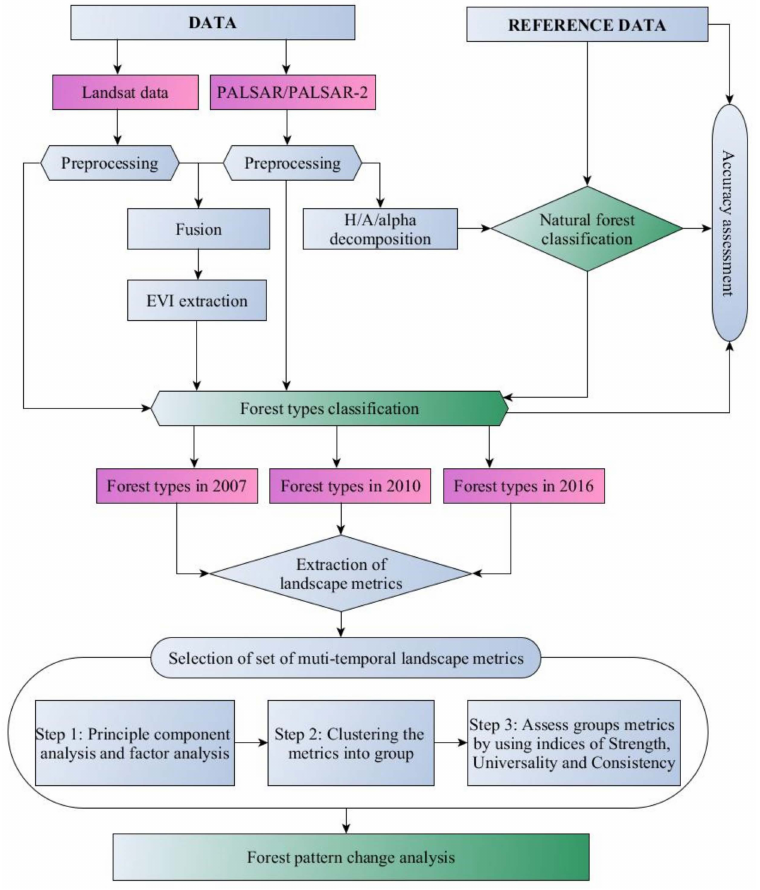
Figure 2. Flowchart of the methodology employed in this